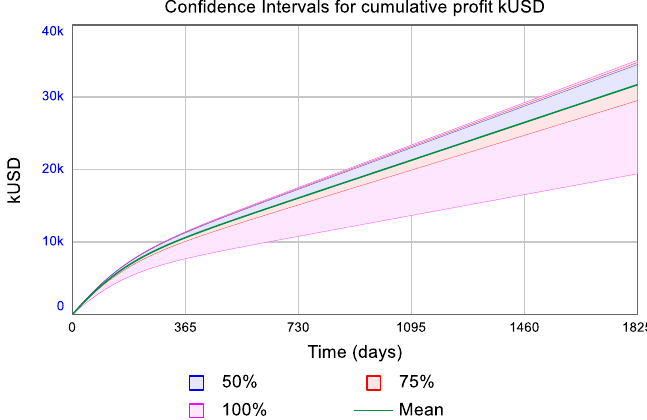
Figure 10. Cumulative profit over five years (1825 days) for different values of the time between two consecutive maintenance events. The mean value and confidence intervals are shown. consecutive maintenance events. The mean value and confidence intervals are